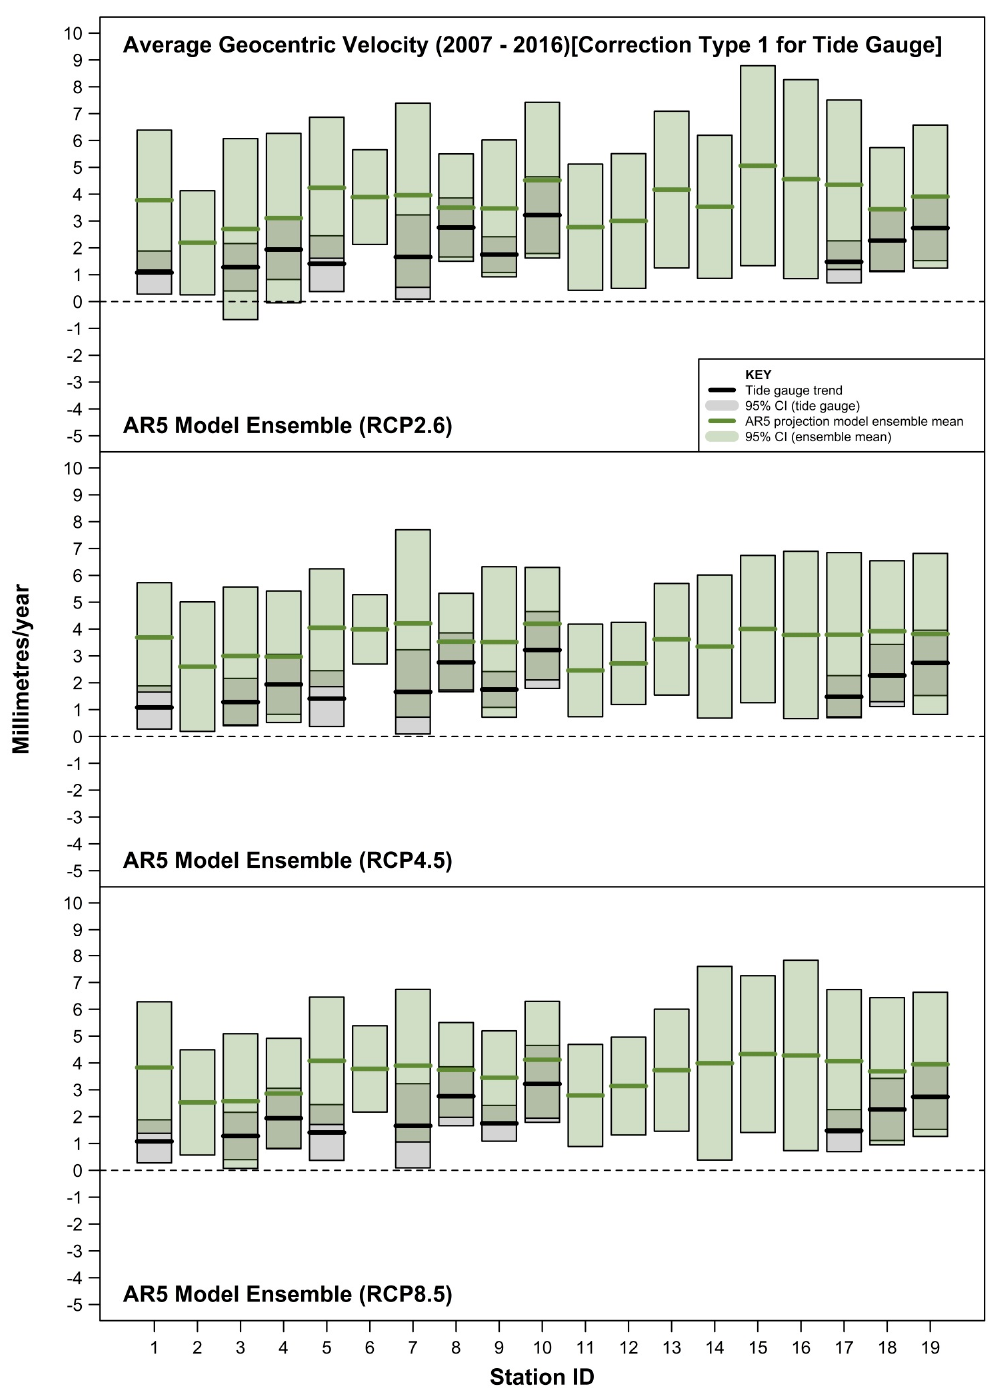
Figure 4. Average “geocentric” velocity determined over the period of common coverage (2007–2016) using Type 1 correction for VLM. Type 1 corrections are based on direct GPS measurements at or near the tide gauge. These charts directly compare the observational record (tide-gauge analysis) and corresponding AR5 ensemble-model projections at the grid point of interest. Refer to Figure 1 and Table 1 for station ID details.